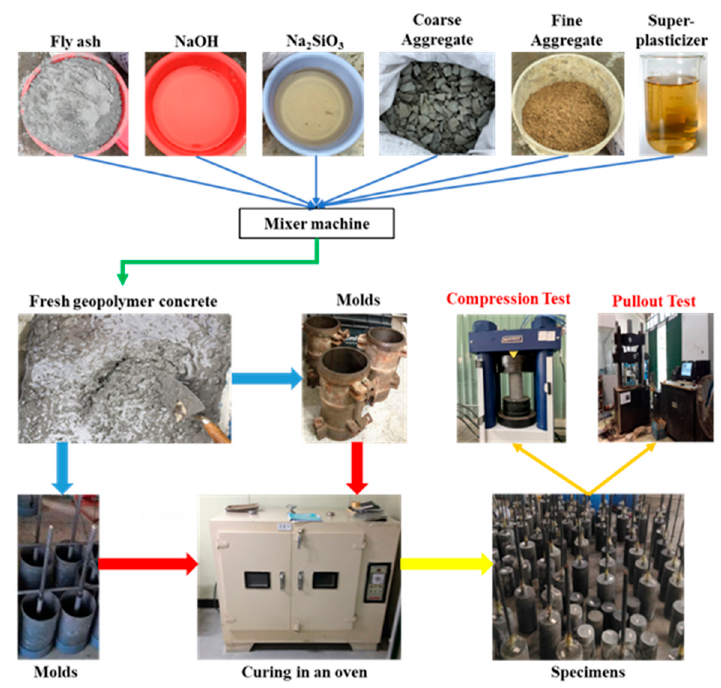
Figure 1. Testing program of this research.